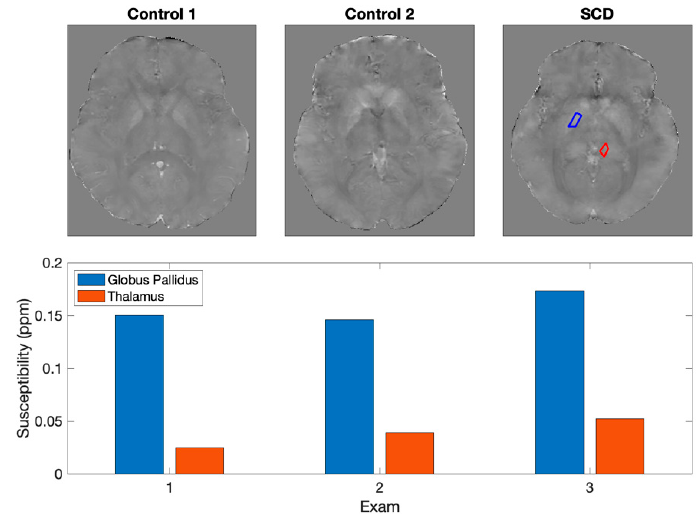
Figure 1. Representative QSM maps from two healthy controls compared to one subject with sickle cell disease demonstrating elevated iron accumulation. This cross-sectional data shows the utility of imaging many patients, which provides a reference between patients with healthy brains and matched patients with elevated iron accumulation.